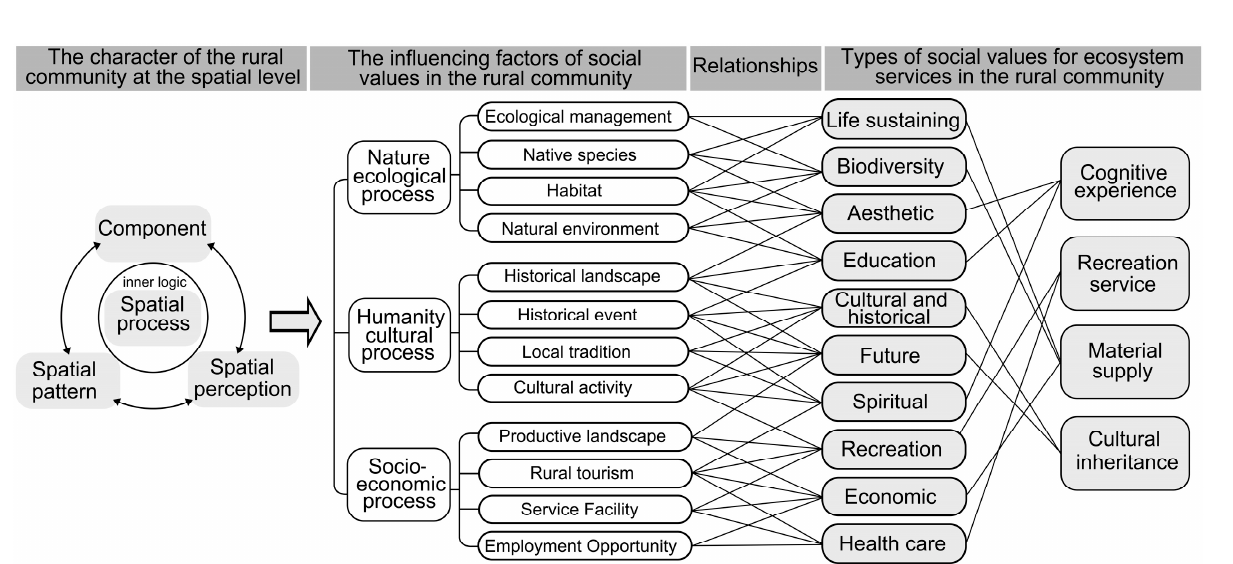
Figure 2. The relationships between character of the rural community and social values for rural ecosystem services.